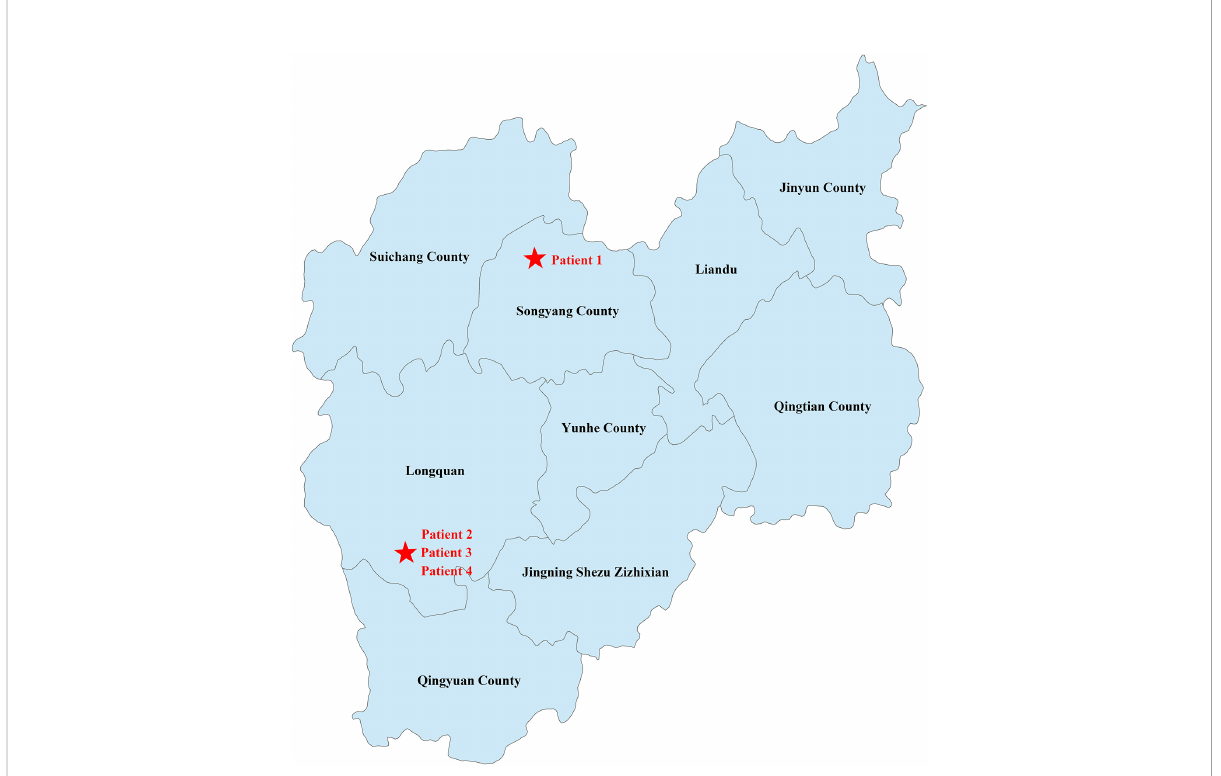
FIGURE 2 Geographical distribution of the cases. The geographic location of the family has been marked with a red fi ve-pointed